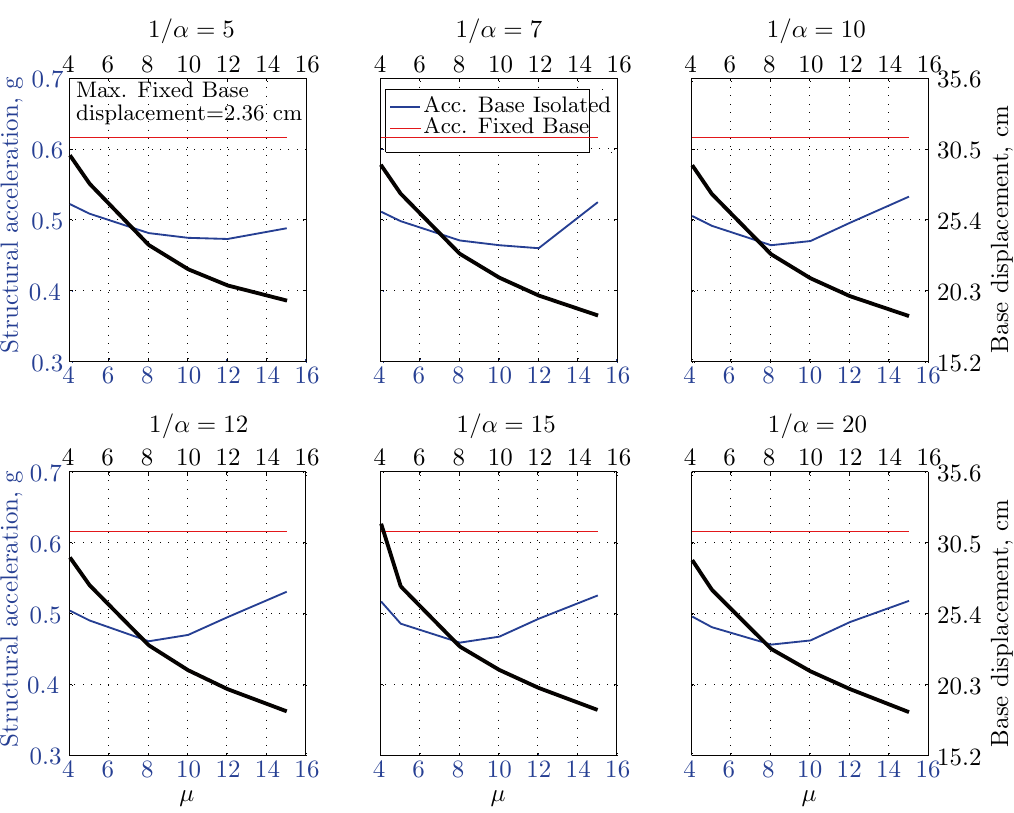
Figure 18. Peak responses of BI-structures subjected to Loma Prieta 1989 (Hollister